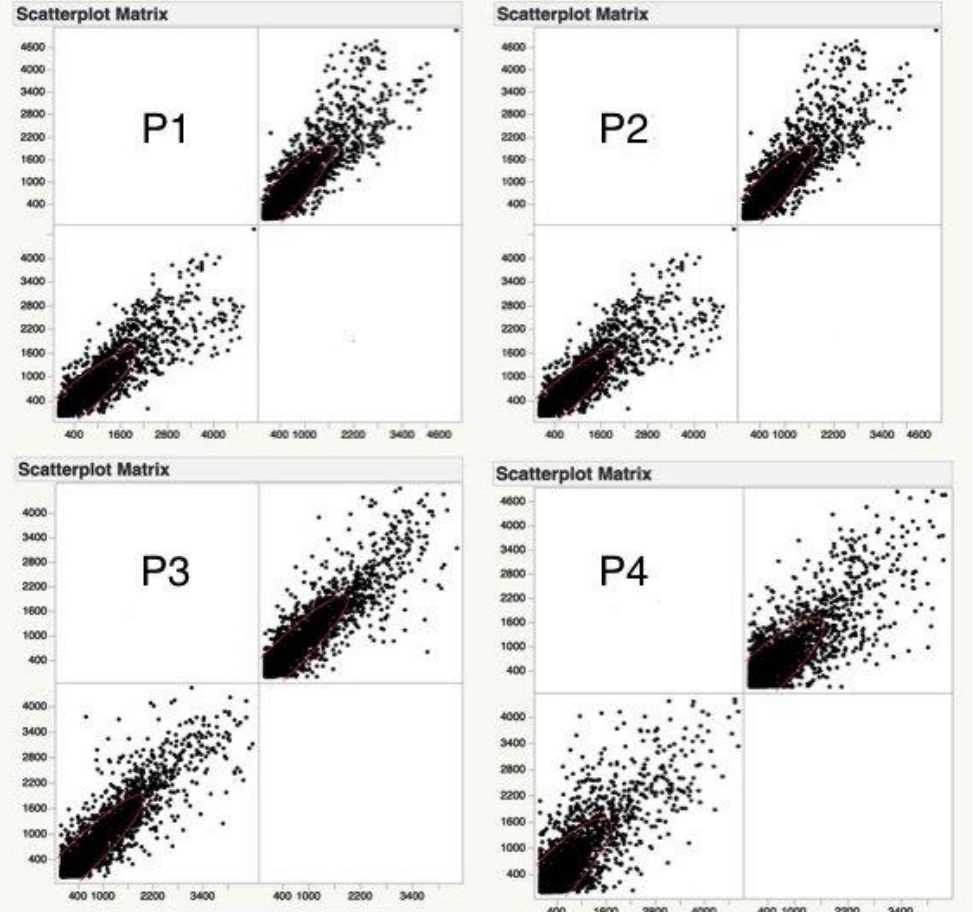
Figure 1 . Scatterplot matrix of activity count data for P1-P4. The x-axis is activity count for Device 1 and the y- axis is activity count for Device 2. Each point on the graph is the activity level for one placement at one epoch for all six dogs. The graphs were visually inspected for